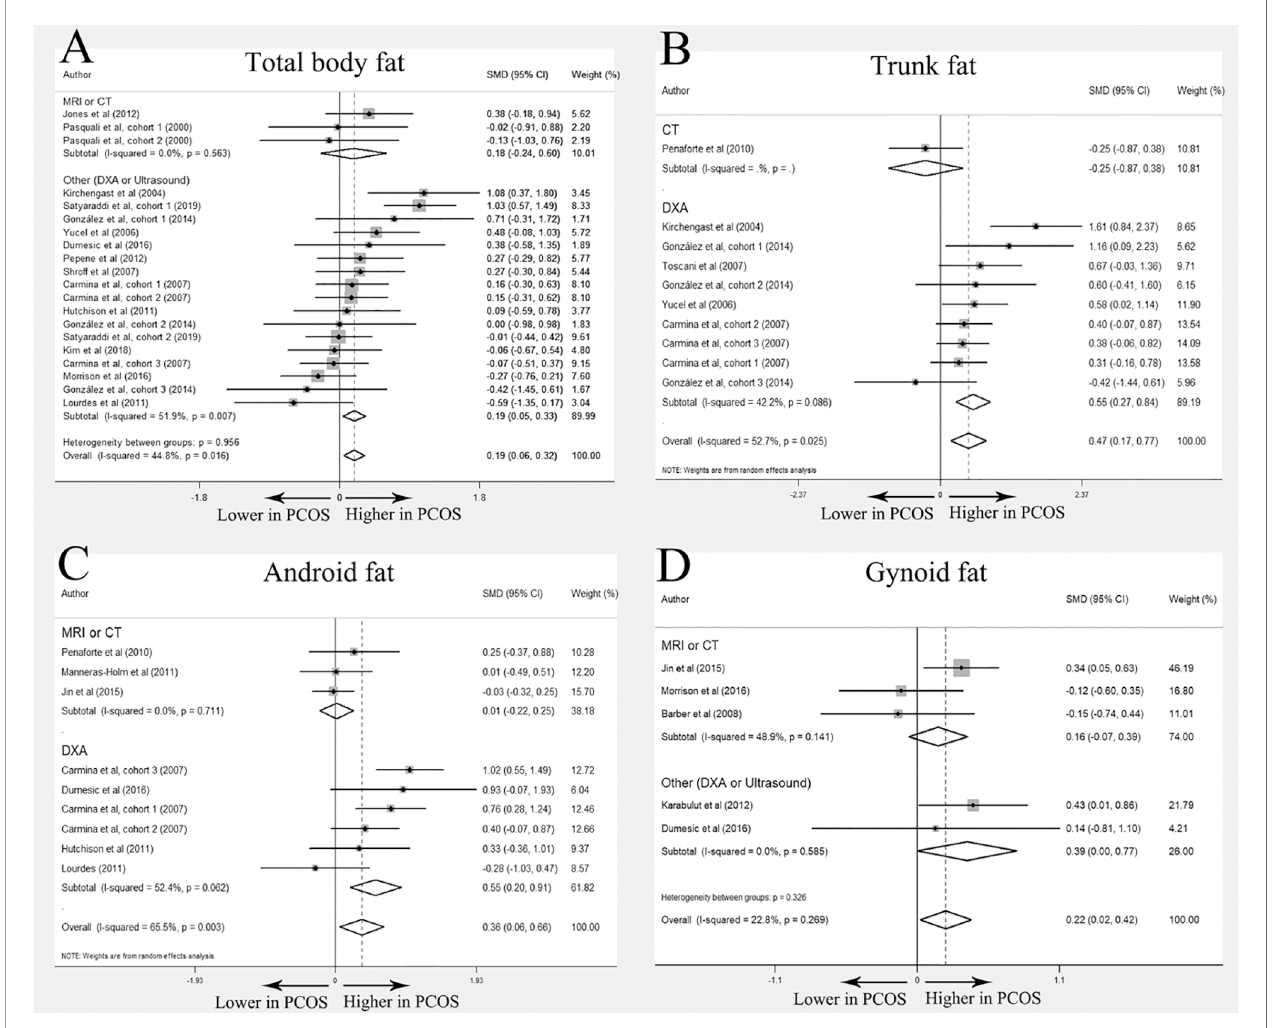
FIGURE 3 | Meta-analysis on total body fat, trunk fat, android fat and gynoid fat (in quantity): women with PCOS versus BMI-matched healthy controls. Forest plot displayed odds of total body fat (A) , trunk fat (B) , android fat (C) and gynoid fat (D) in subgroups.